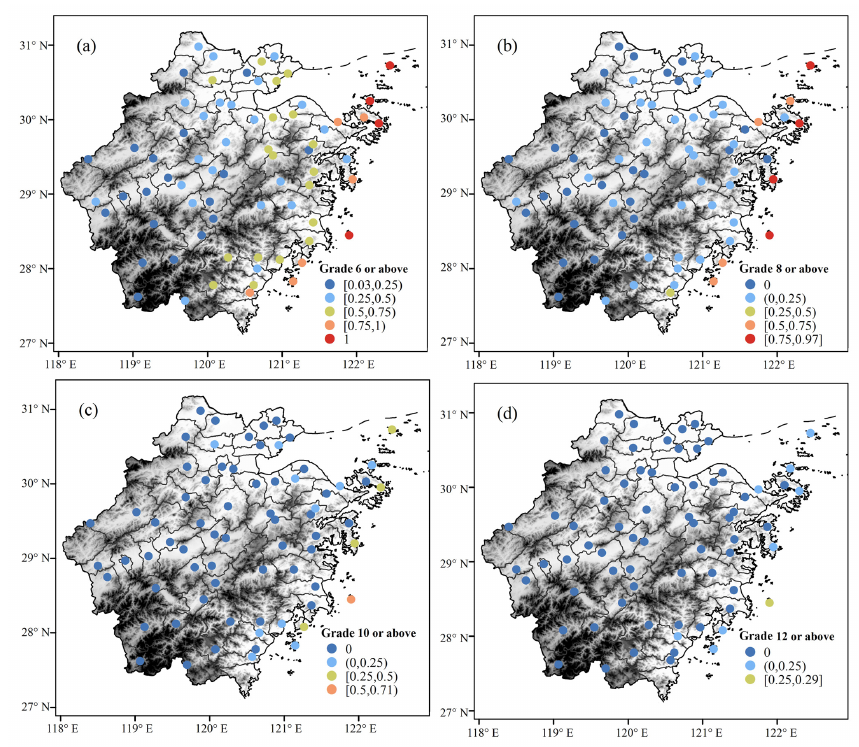
Figure 7. Probability of the occurrence of typhoon winds in Zhejiang Province at (a) grade 6 or above ( ≥ 10 . 8ms − 1 ), (b) grade 8 or above ( ≥ 24 . 5ms − 1 ), (c) grade 10 or above ( ≥ 32 . 7ms − 1 ) and (d) grade 12 or above ( ≥ 41 . 5ms − 1